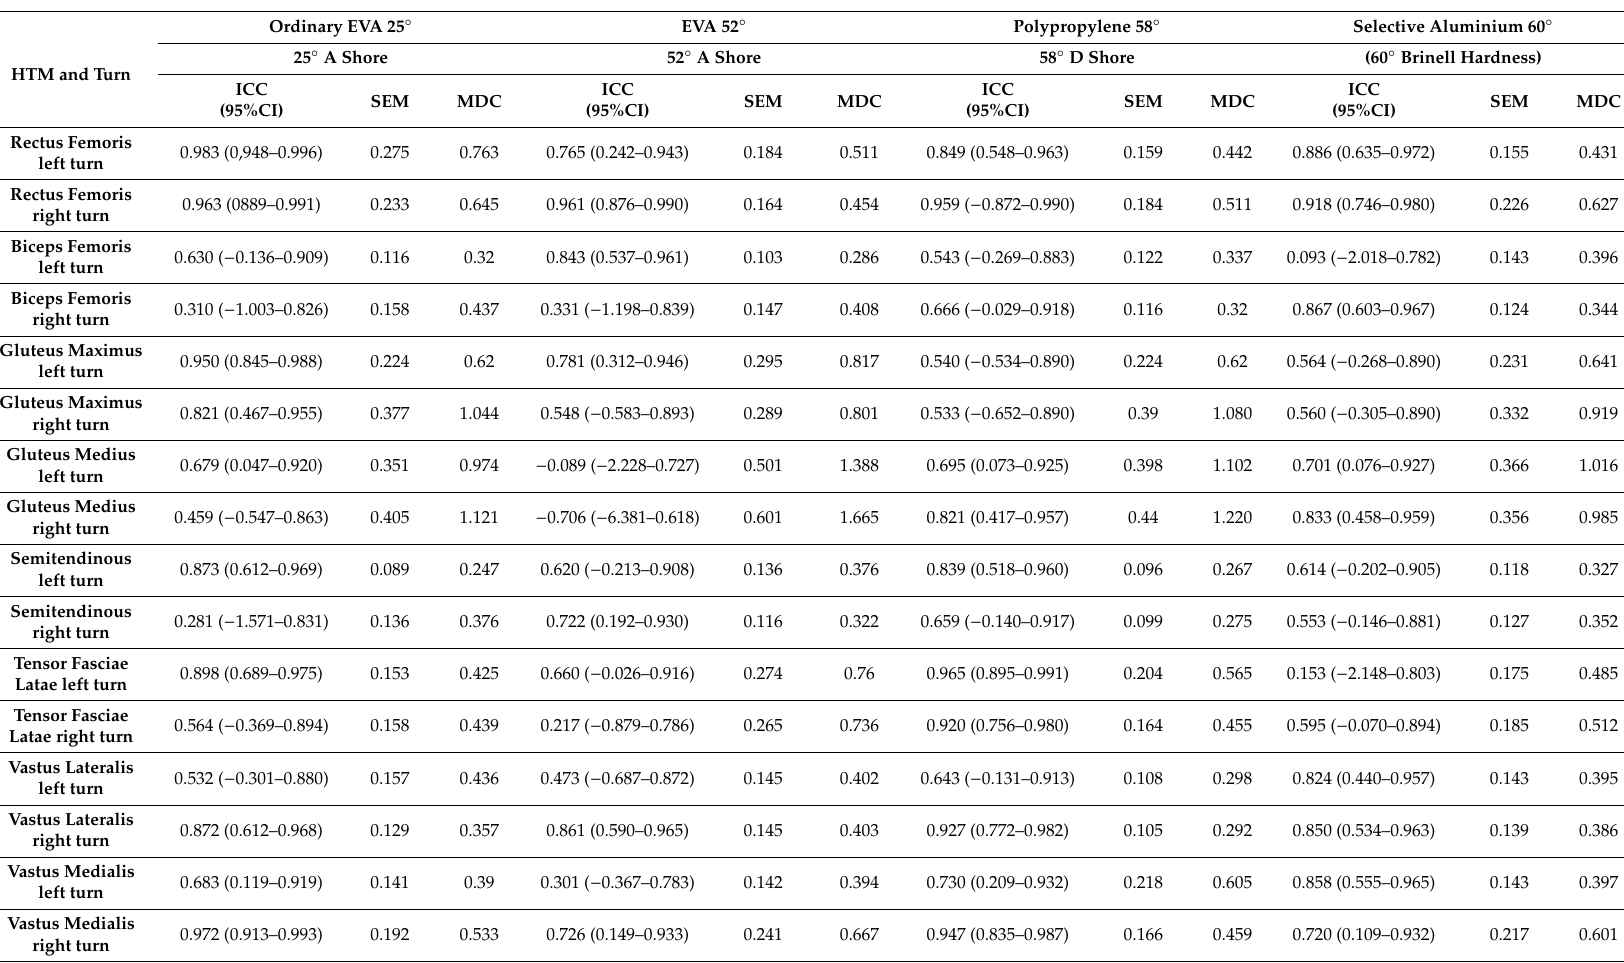
Table 3. Results of the Intraclass correlation coe ffi cient, standard error of measurement and minimal detectable change for electromyography activity patterns of the Hip and Thigh muscles by types of hardness insoles for left and right turns on the